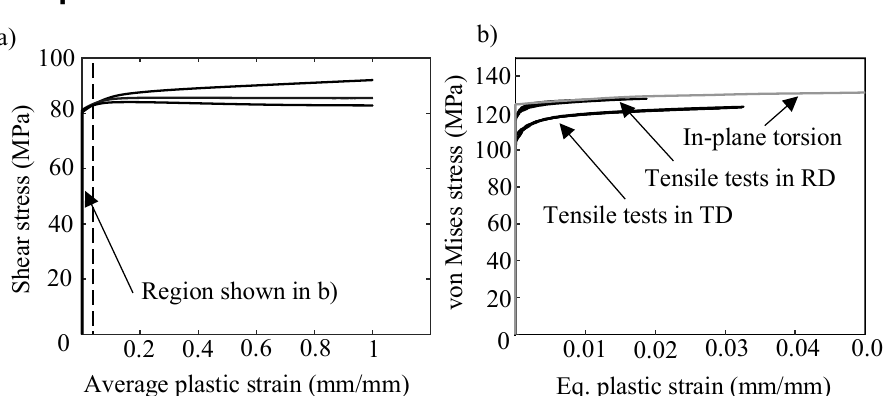
Figure 6 : Comparison of experimental flow curves from tensile tests and in-plane torsion test: (a) 3 in-plane torsion tests having same specimen geometries, and (b) 5 tensile tests in rolling direction (RD) and 4 in the transverse direction (TD) against a single in-plane torsion test to limited strain.